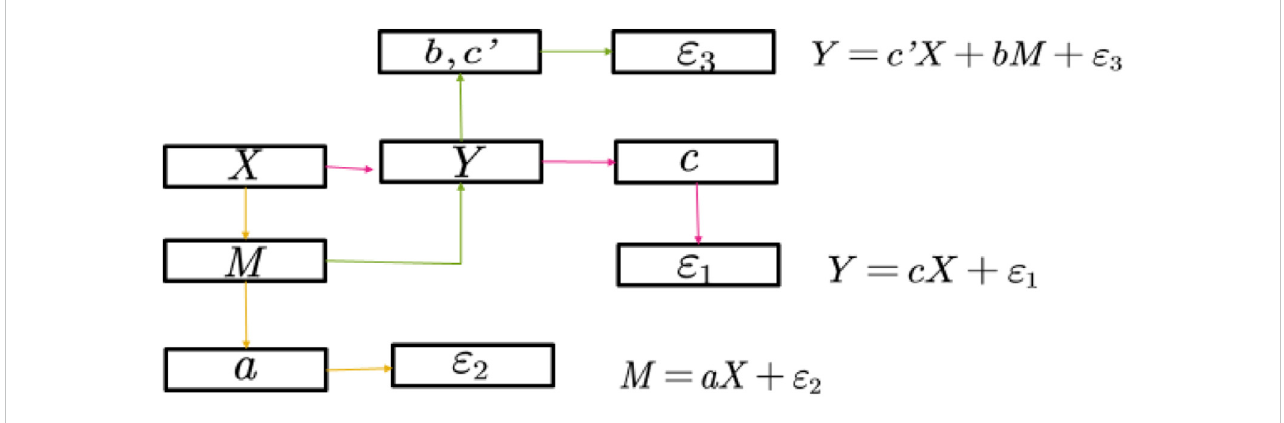
FIGURE 3 Mediating effect test model.